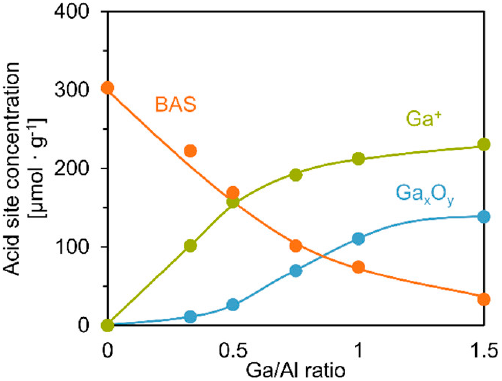
Figure 2. Concentrations of Lewis and Brønsted acid sites of catalysts as a function of the Ga/Al ratio. Reprinted with permission from ref [73]. Copyright 2018 American Chemical Society.